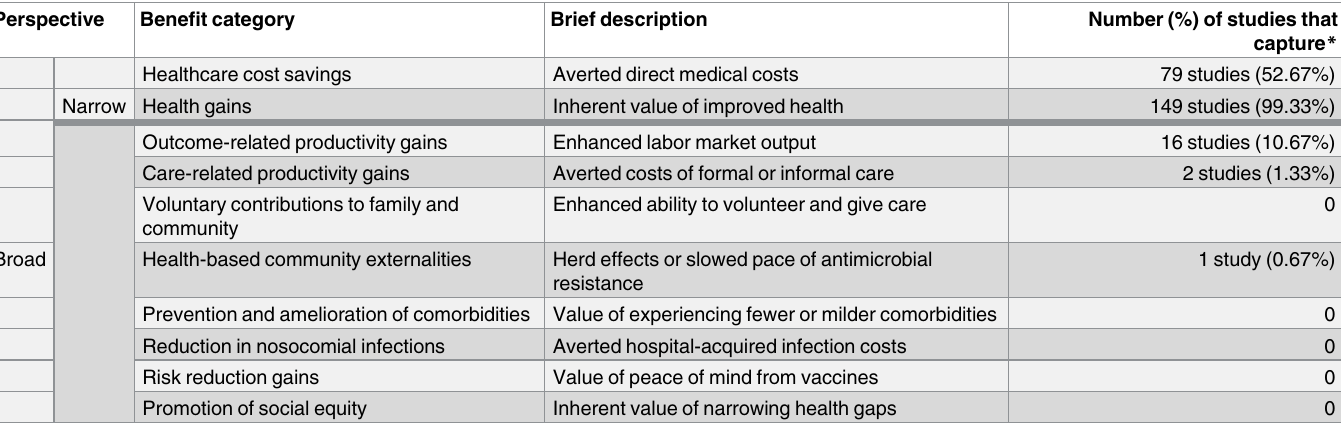
Table 3. Current state of the literature regarding the full benefits of adult pneumococcal